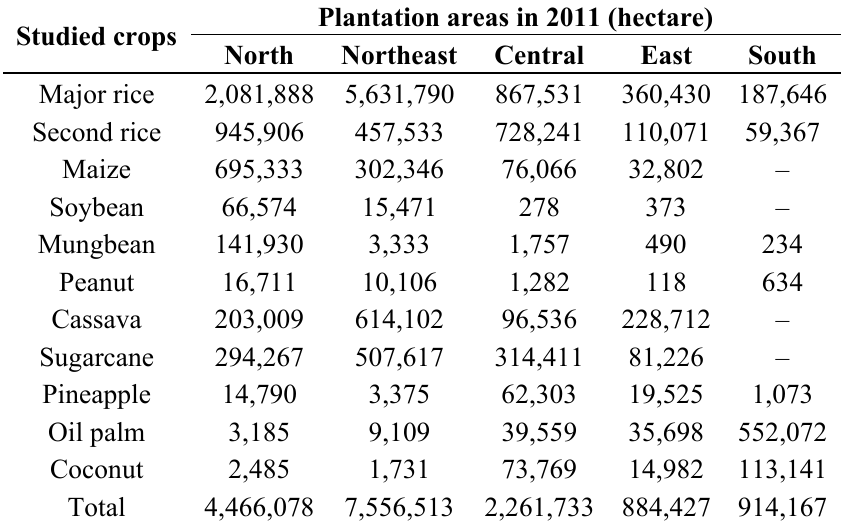
Table 1. Plantation areas of the 10 studied crops classified by